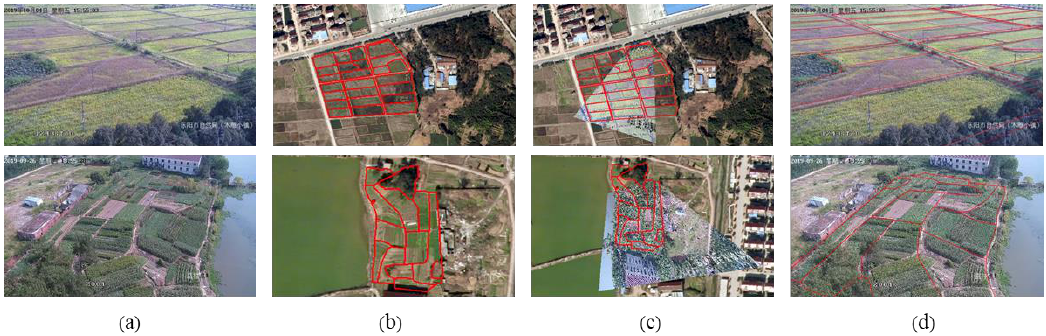
Figure 9. The cross-mapping between 2D BFPZs and the preset video frame of MDXZ (upper row) and JBWF (lower row) dataset. ( a ) The preset video frame. ( b ) The corresponding ortho-image overlaid with 2D vector BFPZs. ( c ) The preset video frame projected into the geospatial space. ( d ) The 2D vector BFPZs projected into the image space.